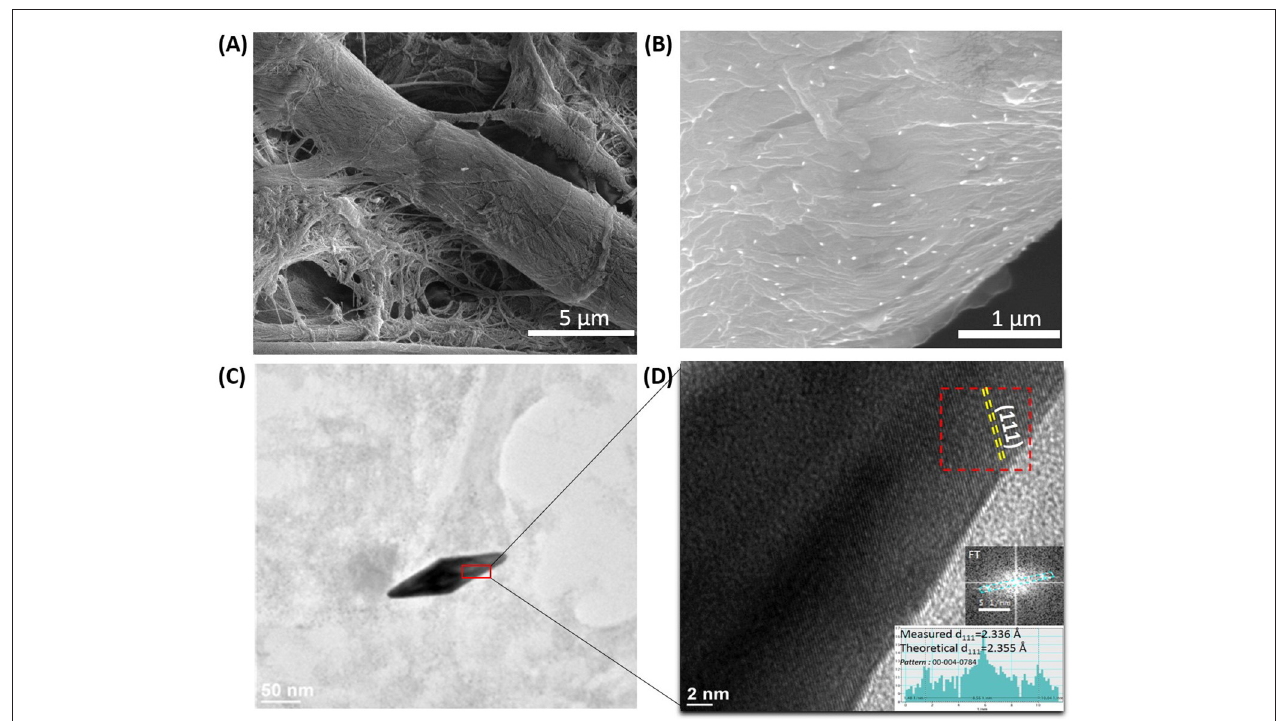
FIGURE 2 | Representative SEM images of the bare Whatman paper (A) and the selected paper@AuBPs800 calligraphed nanoplatform (B) ; HRTEM microscopic image of a single AuBP at high resolution (C) ; HRTEM image showing the (111) family planes faces of the AuBPs. Inset: the Fourier transform made on the marked region and its measurements (D)